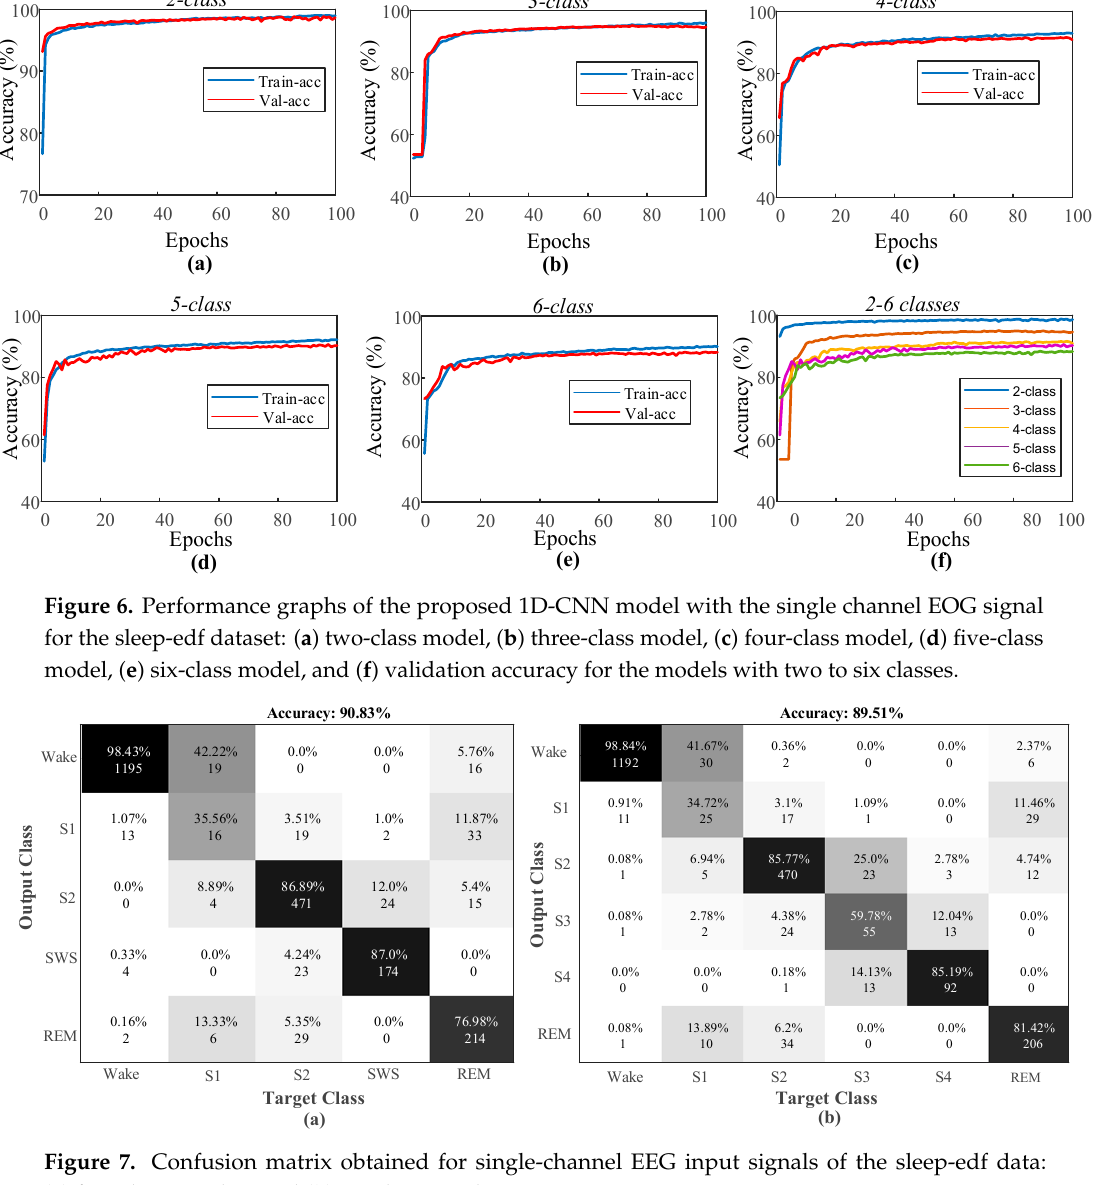
Figure 7 . Confusion matrix obtained for single-channel EEG input signals of the sleep-edf data: ( a ) five-class test data and ( b ) six-class test data.